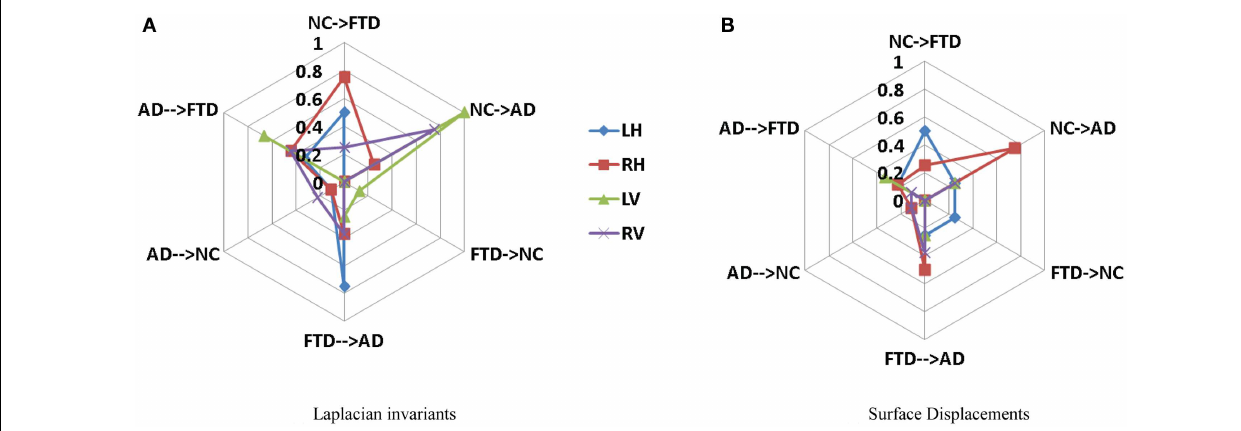
FIGURE 8 | Comparison of multi-class misclassification rates for Laplacian invariant and surface displacement features of both hippocampus and ventricles .The cobweb plot enables an intuitive comparison of the misclassification rates for multiple features. Each axis ranges from 0 at the center (no misclassification) and extends outwards to 1 (100% misclassification). For example, the top axis “AD → FTD” refers